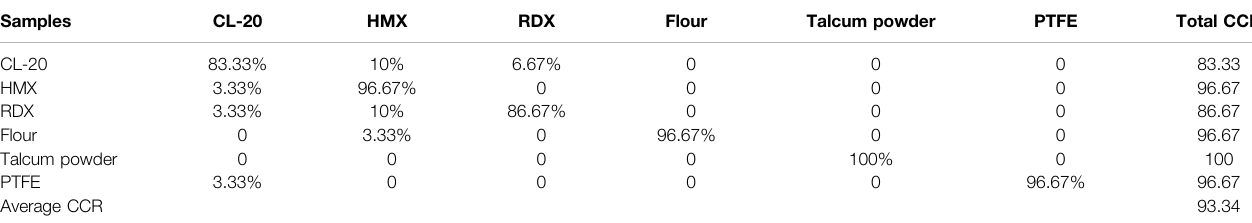
TABLE 2 | Correct classi fi cation rate of SVM1 model using full spectra.